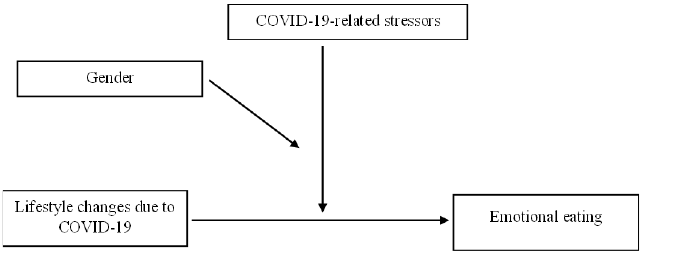
Figure 1. The moderating effect of gender and COVID-19-related stressors on the relationship between lifestyle changes due to COVID-19 and emotional eating.